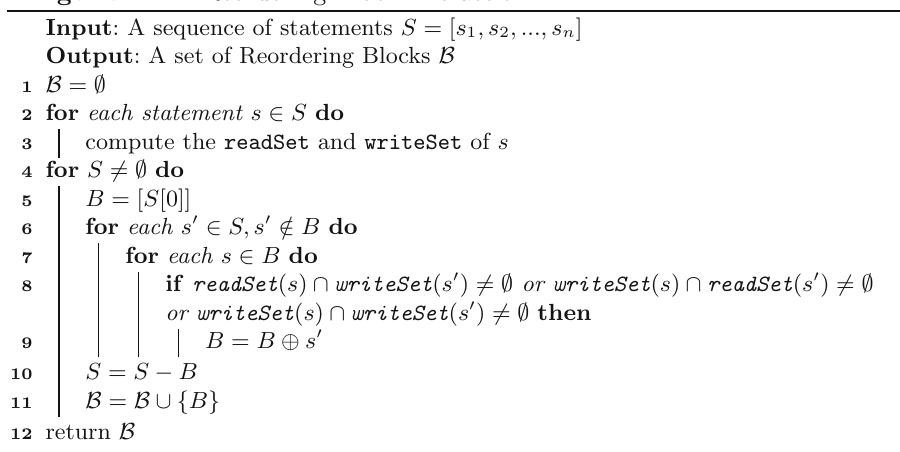
Algorithm 1: Reordering Block